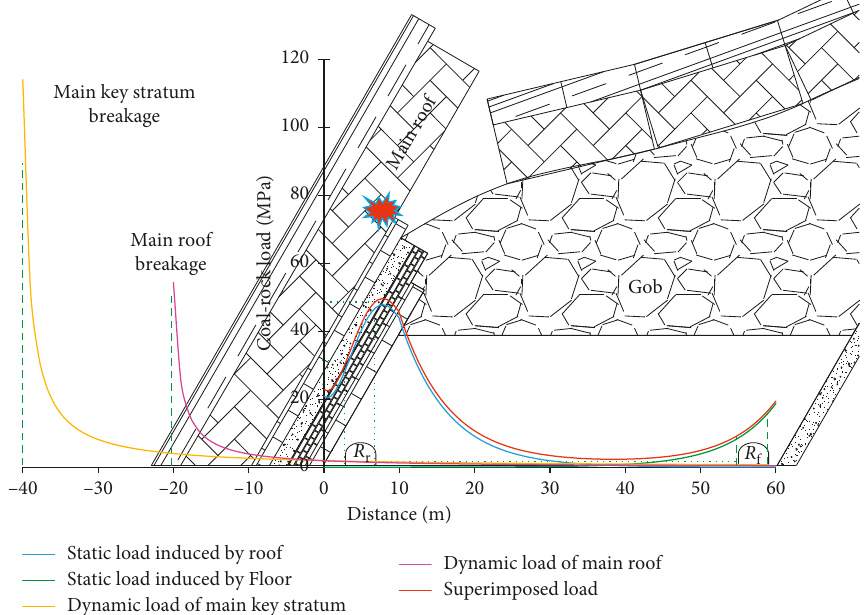
Figure 2: Distribution of dynamic load induced by roof breakage and static stress of the working face.